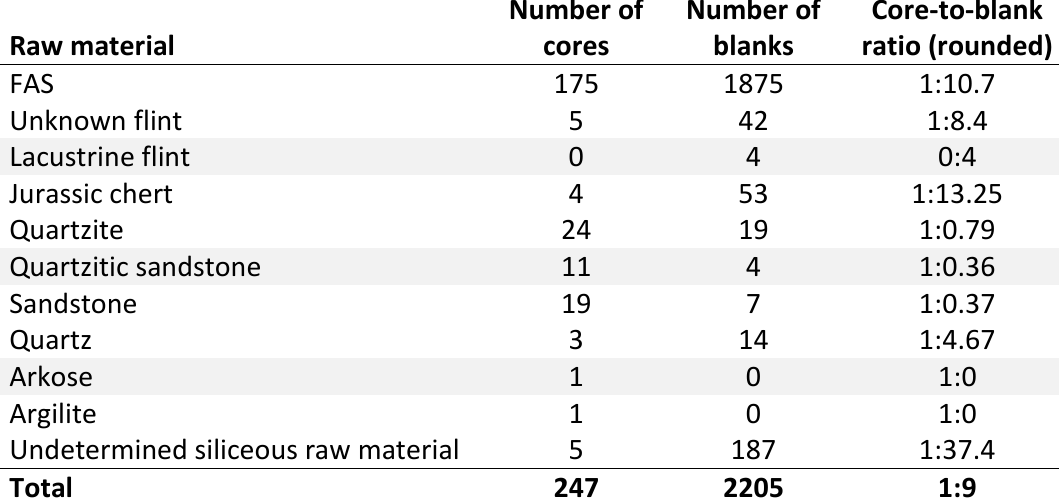
Table 4. Core-to-blank ratio by lithic raw material. (Number of cores = cores-on raw pieces, cores-on-blanks and cores-on-frost